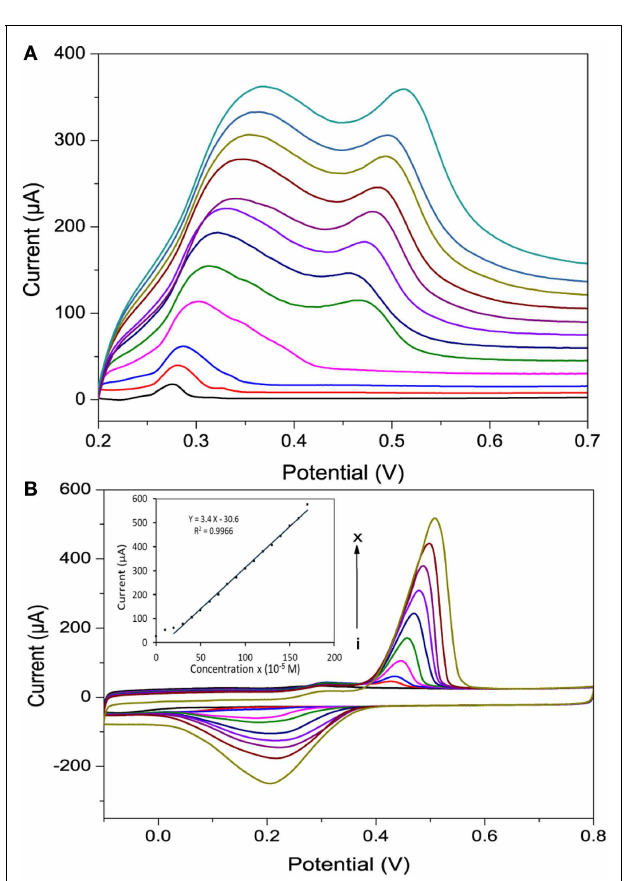
FIGURE 8 | (A) A linear sweep voltammograms recorded using po-Gr/PEDOT:PSS-modified GCE in 0.4mM Hg 2 + + 0.05M HNO 3 at various scan rates (1–100mV/s) and (B) cyclic voltammograms of different concentration of Hg 2 + . (i) 0.0, (ii) 0.1, (iii) 0.2, (iv) 0.4, (v) 0.6, (vi) 0.8, (vii) 1.0, (viii) 1.2, (ix) 1.4, and (x) 1.6mM (inset shows the corresponding calibration curve) in 0.05M HNO 3 medium using po-Gr/PEDOT:PSS-modified GCE at a scan rate of